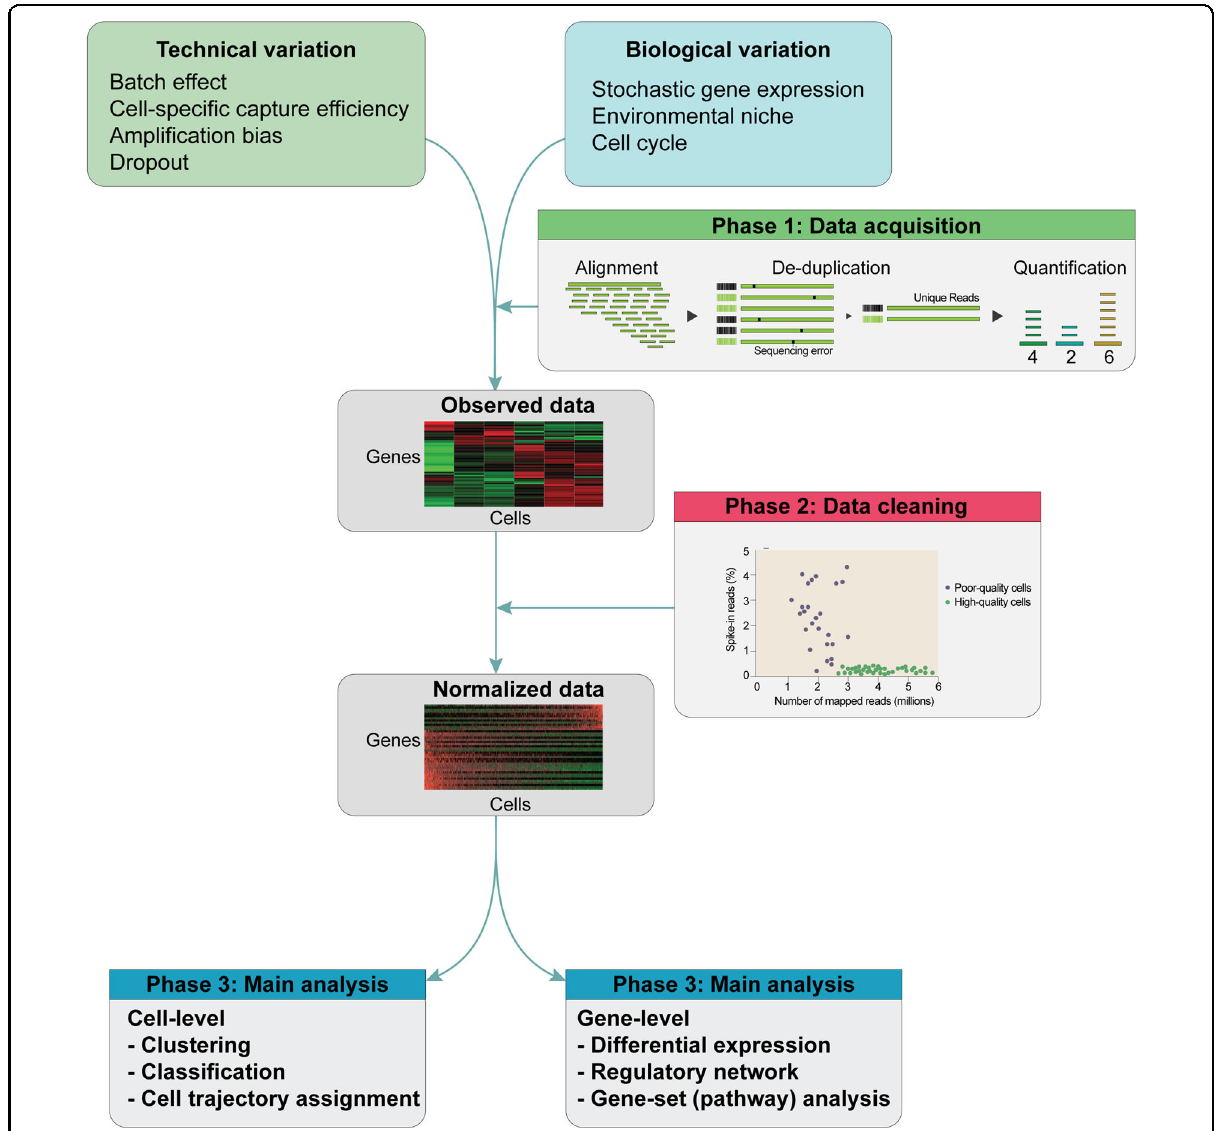
Fig. 2 A schematic overview of scRNA-seq analysis pipelines. scRNA-seq data are inherently noisy with confounding factors, such as technical and biological variables. After sequencing, alignment and de-duplication are performed to quantify an initial gene expression pro fi le matrix. Next, normalization is performed with raw expression data using various statistical methods. Additional QC can be performed when using spike-ins by inspecting the mapping ratio to discard low-quality cells. Finally, the normalized matrix is then subjected to main analysis through clustering of cells to identify subtypes. Cell trajectories can be inferred based on these data and by detecting differentially expressed genes between